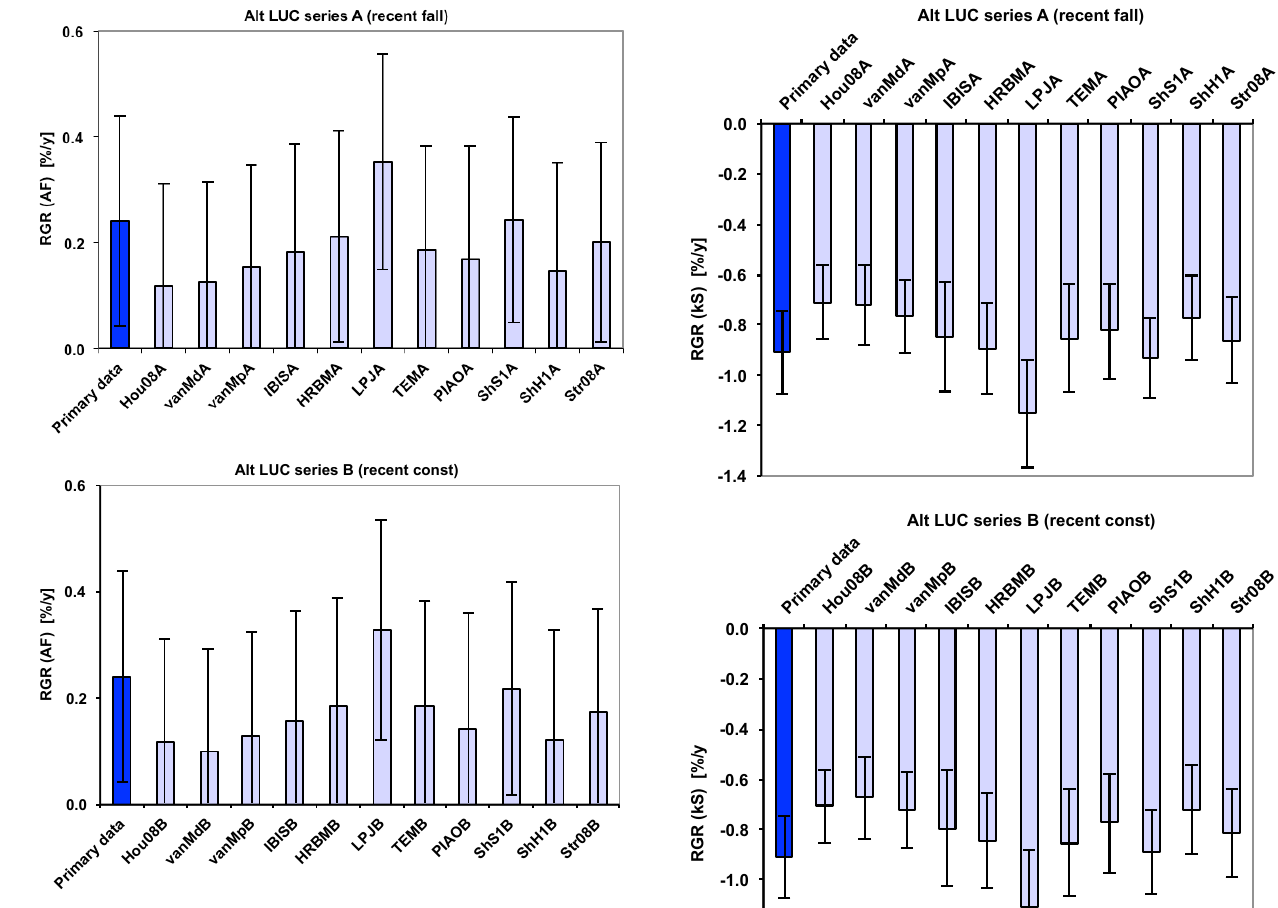
Figure D4. Estimates of RGR ( AF ) using primary data for f LUC Figure D4 (source: aaTrendEstimation.Results.V34.xls) (blue bars) and 11 alternative f LUC trajectories (Table D1 and Fig. D3, pale grey bars). Trends are estimated using Eq. (A2). P val- ues are shown in Table D1. All estimates are computed using data treatment ( m , s , n ) and the combined trend detection method, as for best estimates in Fig. 2 and Tables 1 and 2. Error bars show ± 1 σ confidence intervals. Upper and lower panels show RGR ( AF ) using “recent fall” and “recent const” extrapolations, respectively.